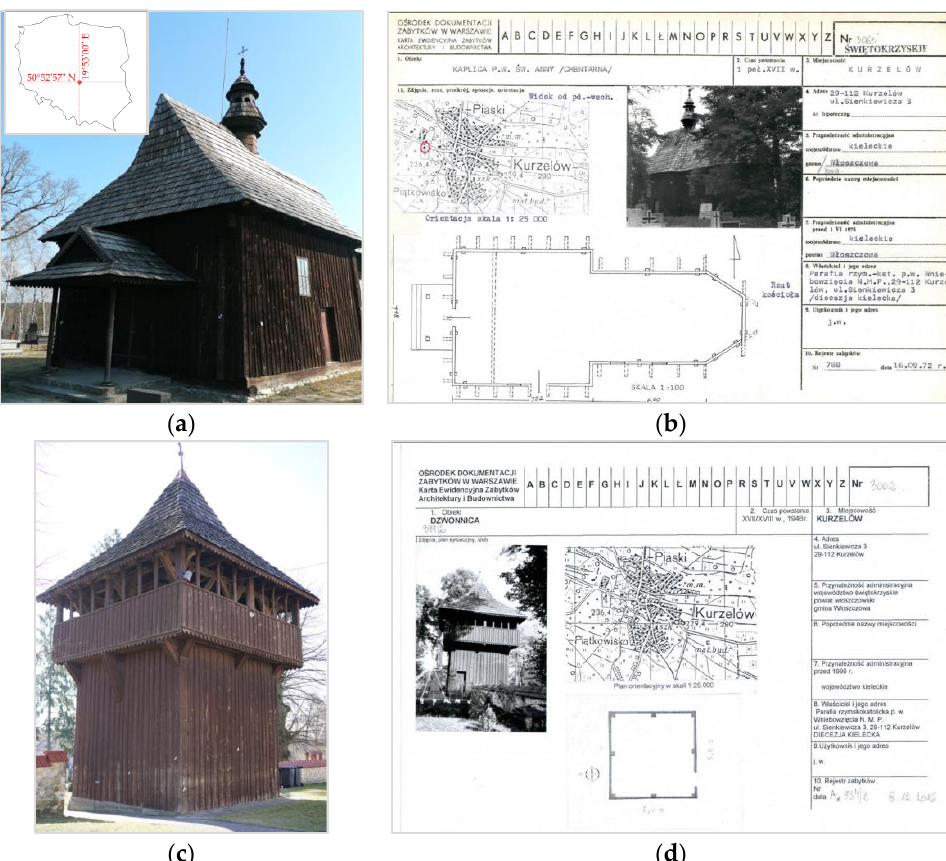
Figure 1. The complex of historic religious buildings ( a ) Chapel of St. Anna; ( b ) A fragment of the — monument card for the chapel [43]; ( c ) The belfry; ( d ) A fragment of the monuments card for the belfry [44].